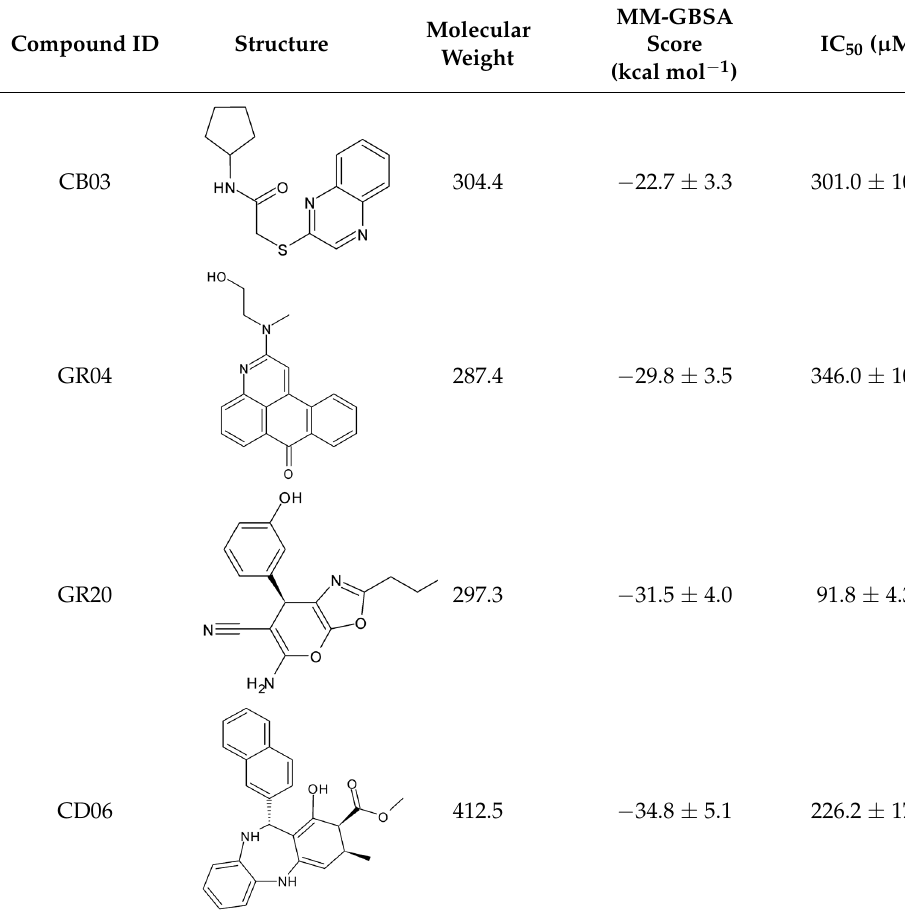
Table 2. IC 50 values of virtual screening top hits.